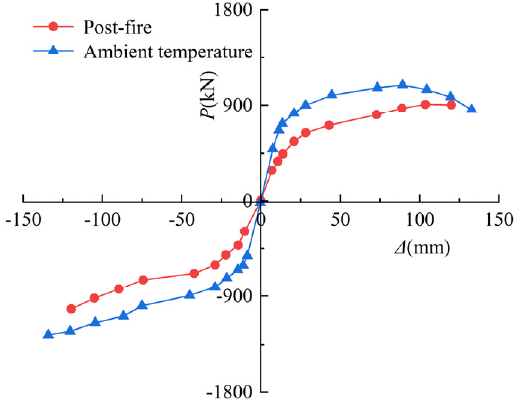
Figure 11. Skeleton curves of P- Δ relations.